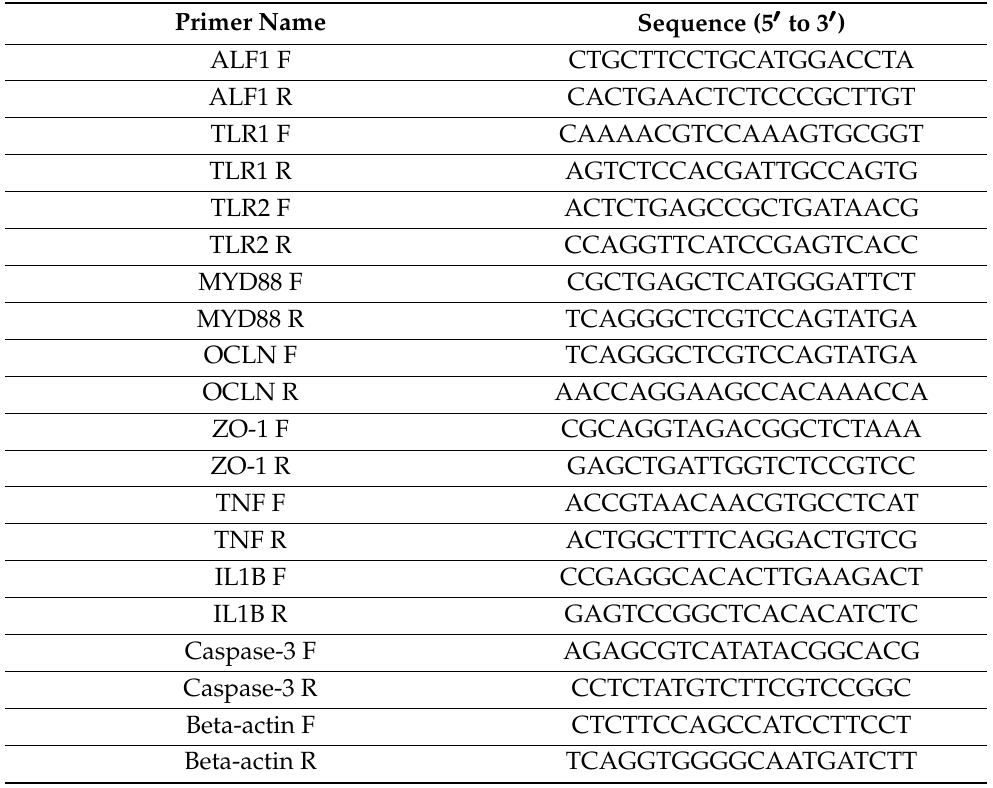
Table 1. Primer names and